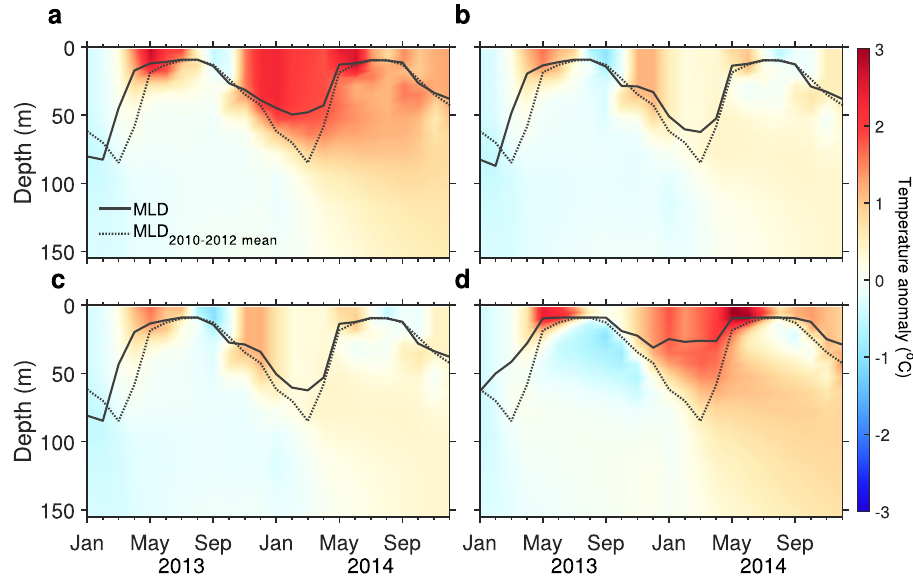
Fig. 7 Vertical pro fi le of temperature anomalies from model outputs. a – d Modeled time series of temperature anomaly vertical pro fi les averaged in the black box (40°N – 50°N, 135°W – 150°W) from the control and the Case 1, Case 2 and Case 3 sensitivity experiments. The black solid lines indicate the mixed layer depth, and the dashed lines are the normal-year (2010 – 2012) averaged MLD.